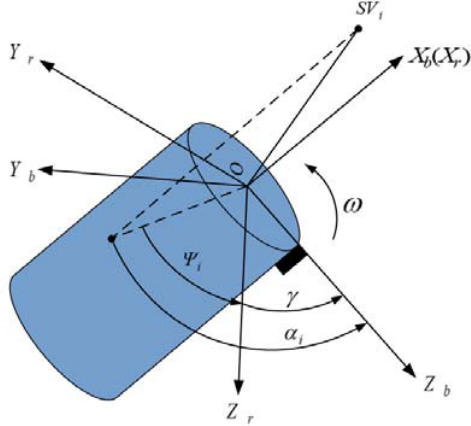
Figure 4. Schematic diagram of roll angle detection.